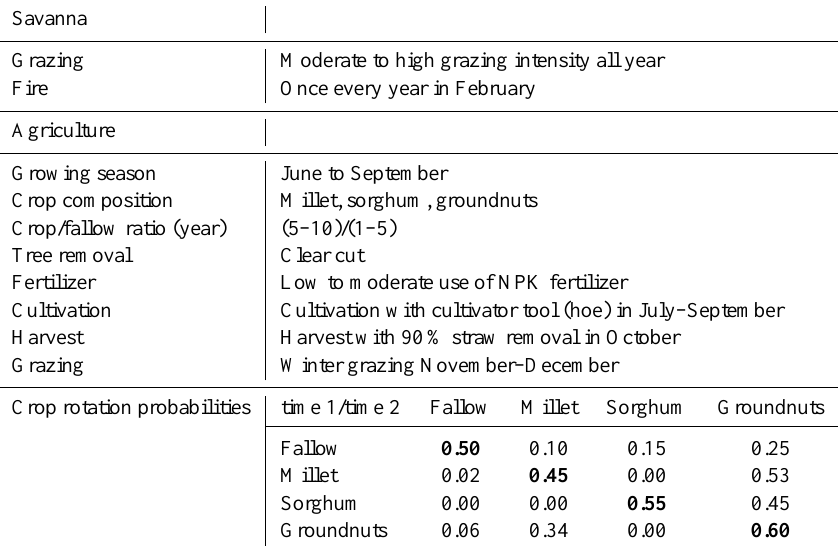
Table 1. Summary of management practices used for the GEMS model parameterization. The crop rotation probabilities should be read horizontally from time 1 to time 2; each row sums to